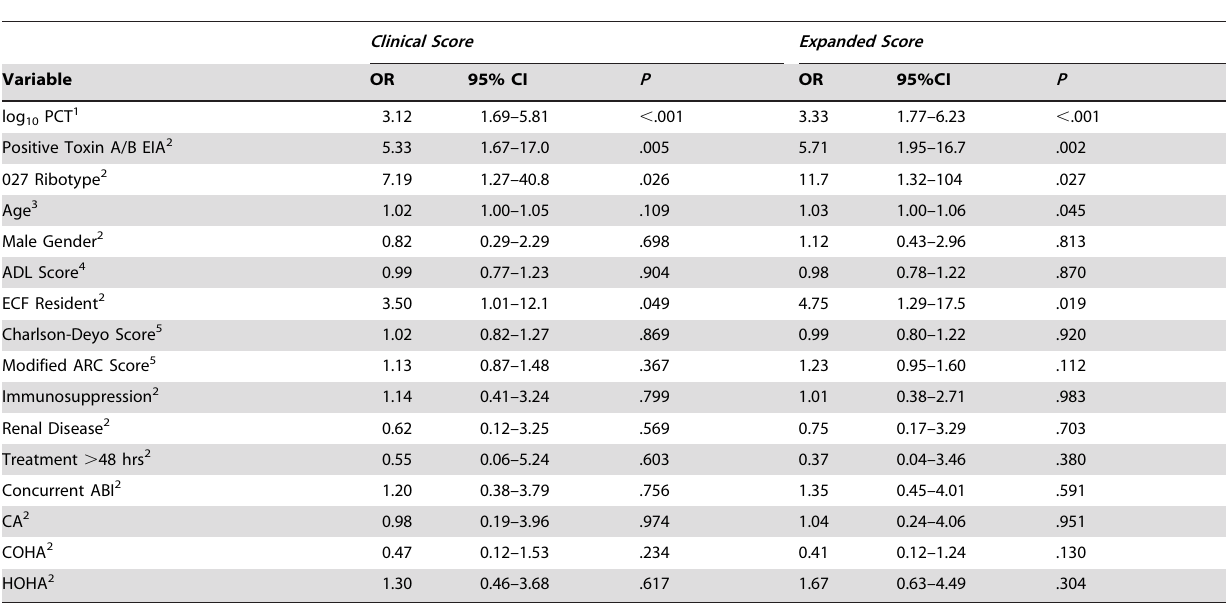
Table 1. Odds ratios for predictors of CDI severity scores based on univariate logistic regression.